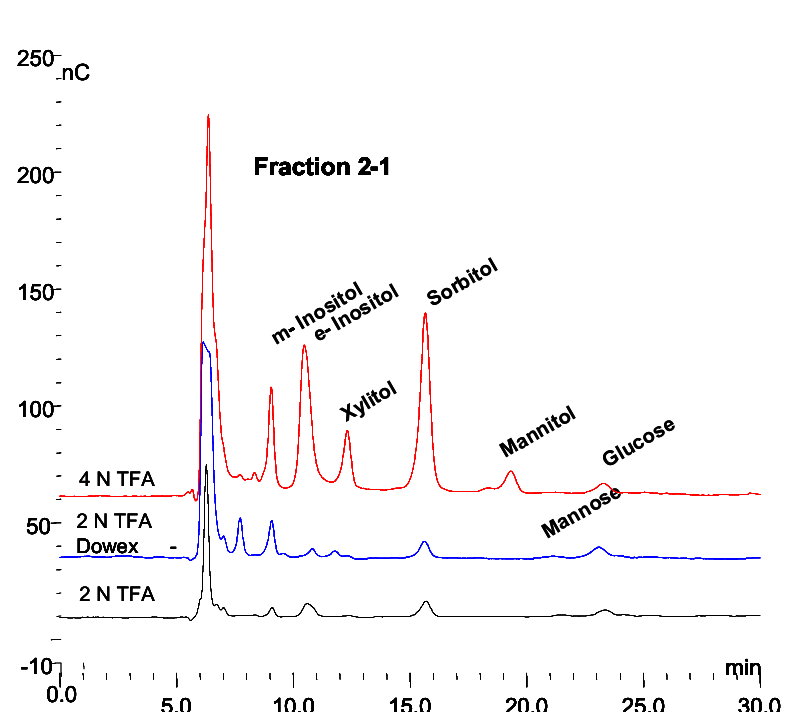
Figure 7. The monosaccharide chromatograms for Fraction 1 (2-1) are shown from bottom to top for 2 N TFA hydrolyzate, Dowex 50W column, and 4 N TFA hydrolyzate.